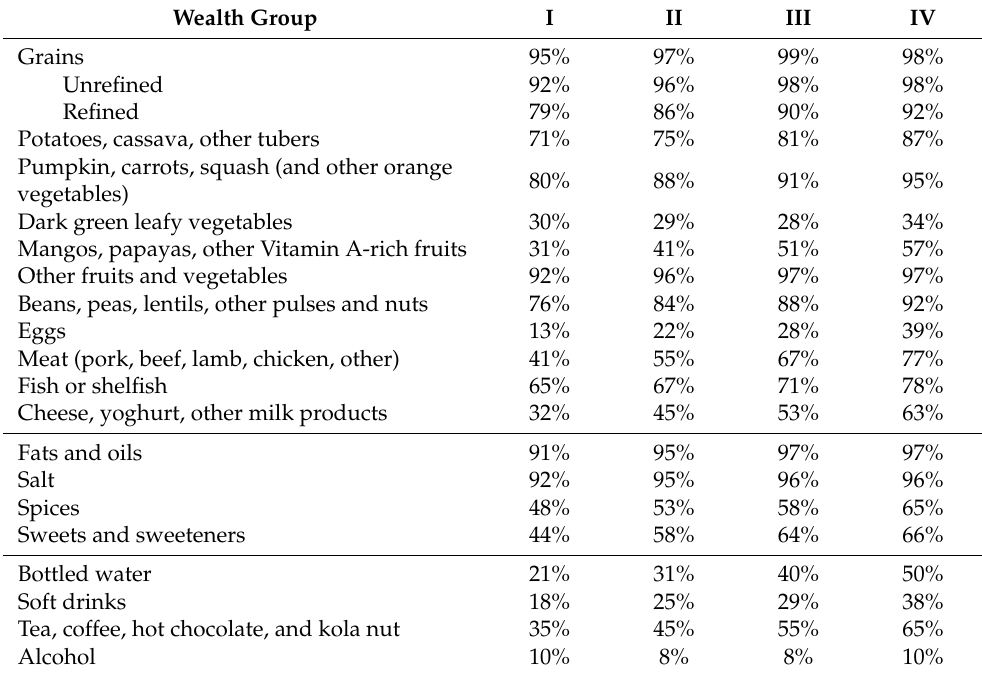
Table 5. Food groups eaten by Nigerian households across different wealth groups in the 7 days prior to the survey (I poorest–IV richest) [12].